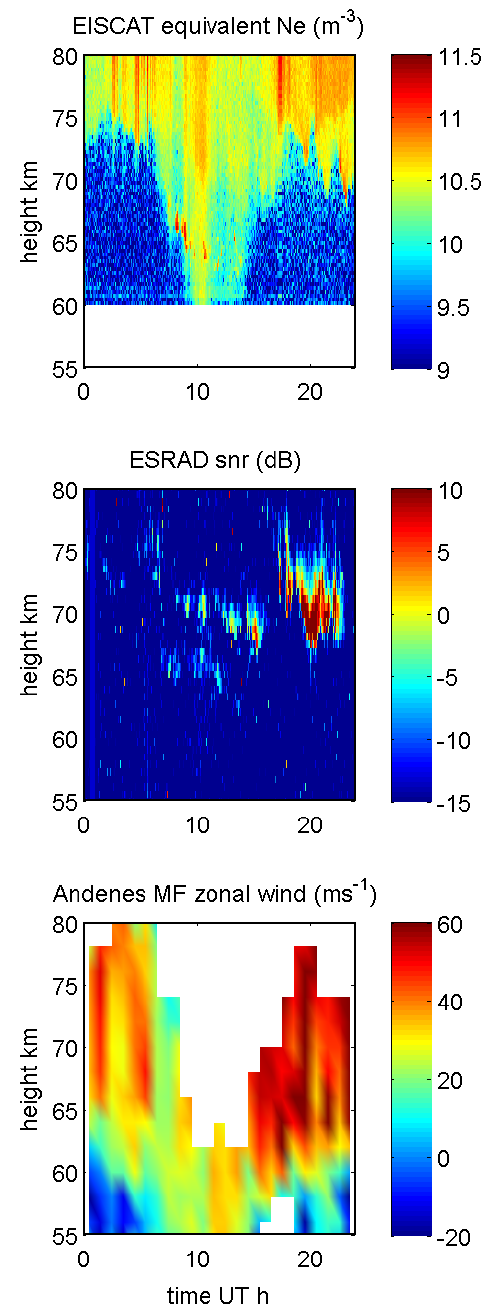
Fig. 1. Overview of observations on 10 November 2004. Upper panel shows equivalent electron densities measured by the EISCAT 224-MHz VHF radar (1-min integrated data), middle panel shows radar echo signal to noise ratio measured by the ESRAD 52-MHz radar (600-m height resolution, 25s average data, one profile each 64s), lower panel shows zonal winds derived from measurements by the Andenes 2-MHz radar (time resolution 1h, height resolution 4km, interpolation used for